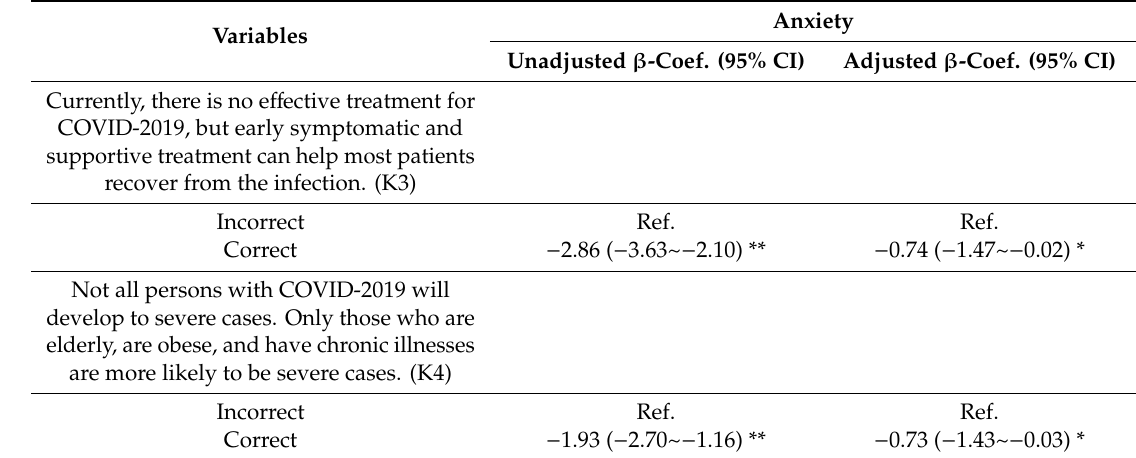
Table 3. Adjusted beta-coe ffi cients and 95% confidence intervals (CIs) of knowledge, attitudes, and practices, and anxiety towards the COVID-19 pandemic among the Indonesian population ( n =